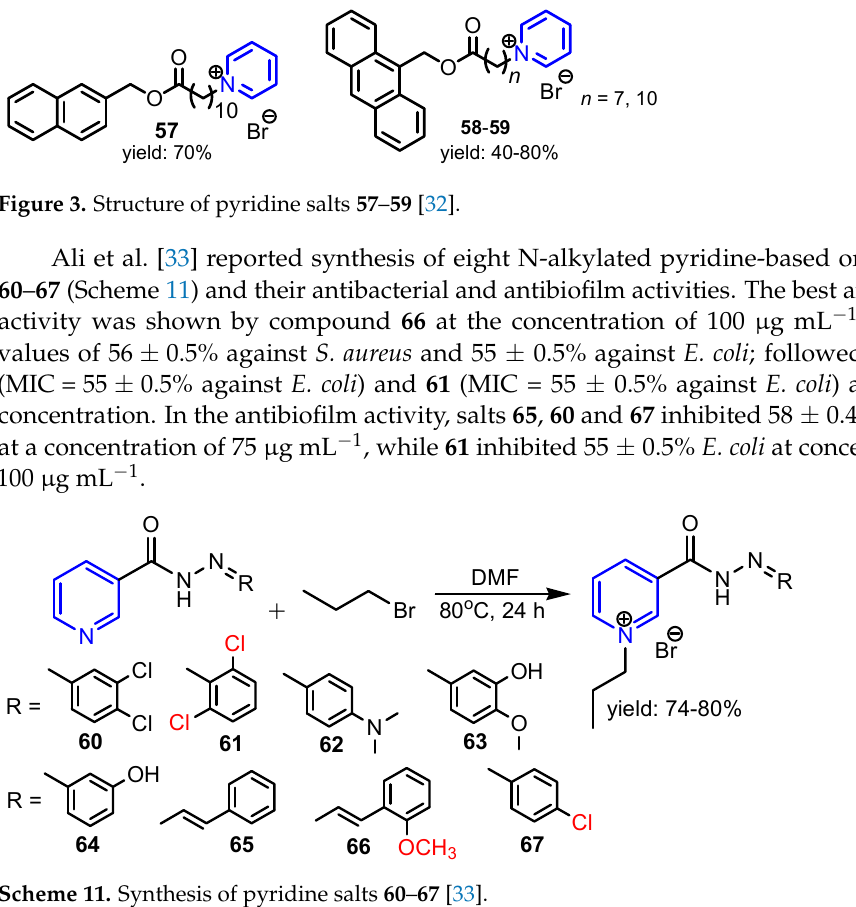
Ralstonia solanacearum , and Xanthomonas axonopodis , because of the appropriate balance between hydrophobicity and hydrophilicity in these molecules.